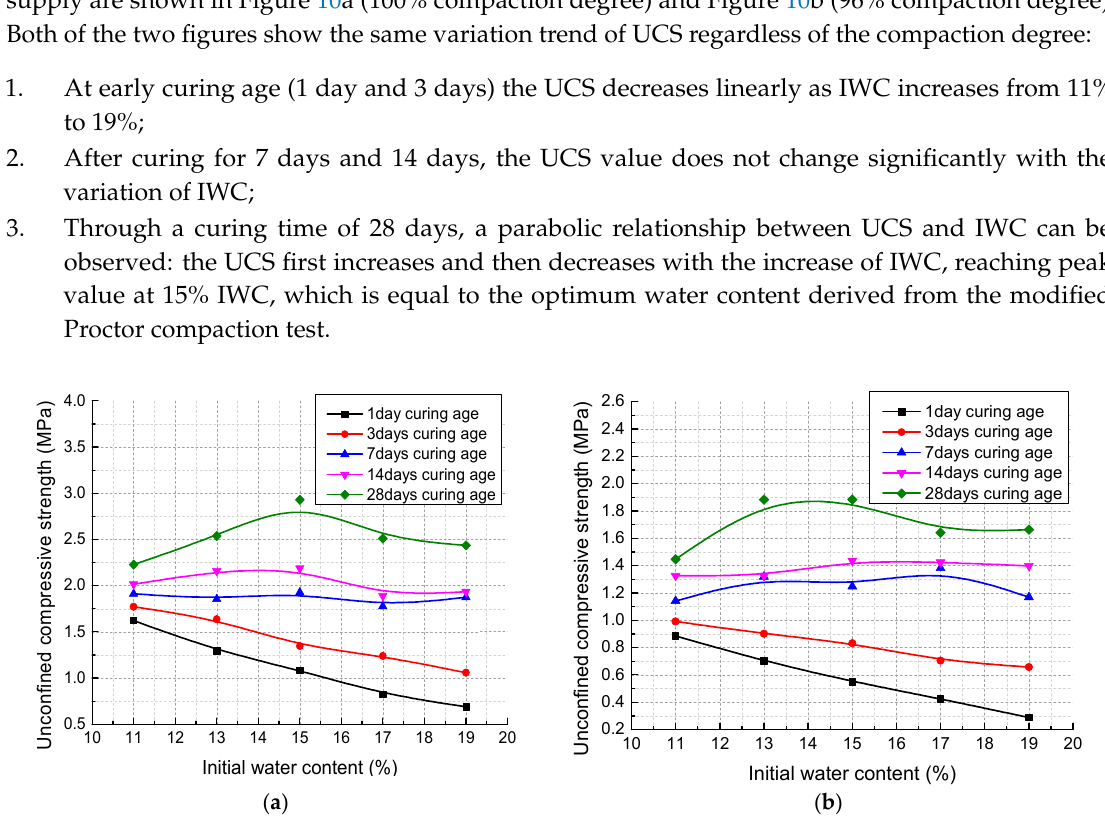
Figure 10. Effects of initial water content on unconfined compressive strength of specimens cured in plastic bags: ( a ) dry density 1.79 g/cm 3 ; ( b ) dry density 1.72 g/cm 3 .